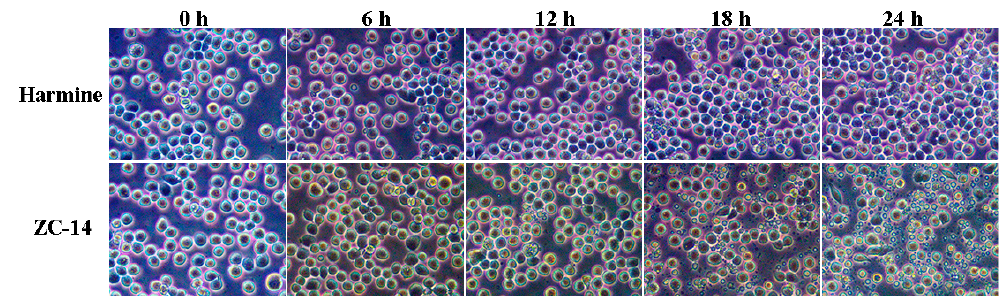
Figure 3. The morphological changes of Sf9 cells treated with 7.5 μ g/mL harmine and ZC-14 by inverted phase contrast microscopy (20×).